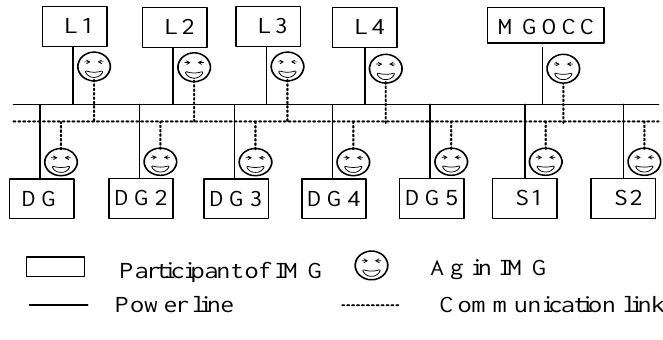
Figure 9. Configuration of agent-based islanded microgrid for Cases 5–6.